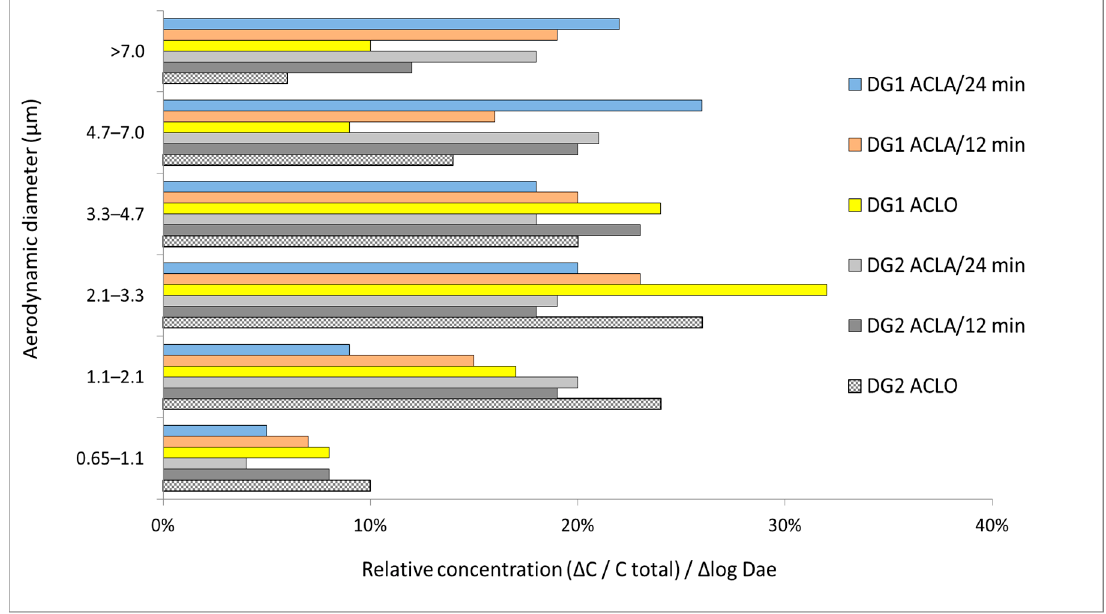
Figure 3. The size distribution of fungal aerosols in dwelling 1 (DG1) and dwelling 2 (DG2) when the air cleaner was active (ACLA) for 12 min and 24 min, or when the air cleaner was turned off (ACLO).